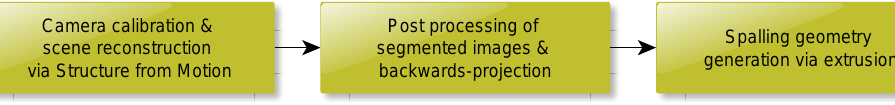
Figure 5. Process for generating the